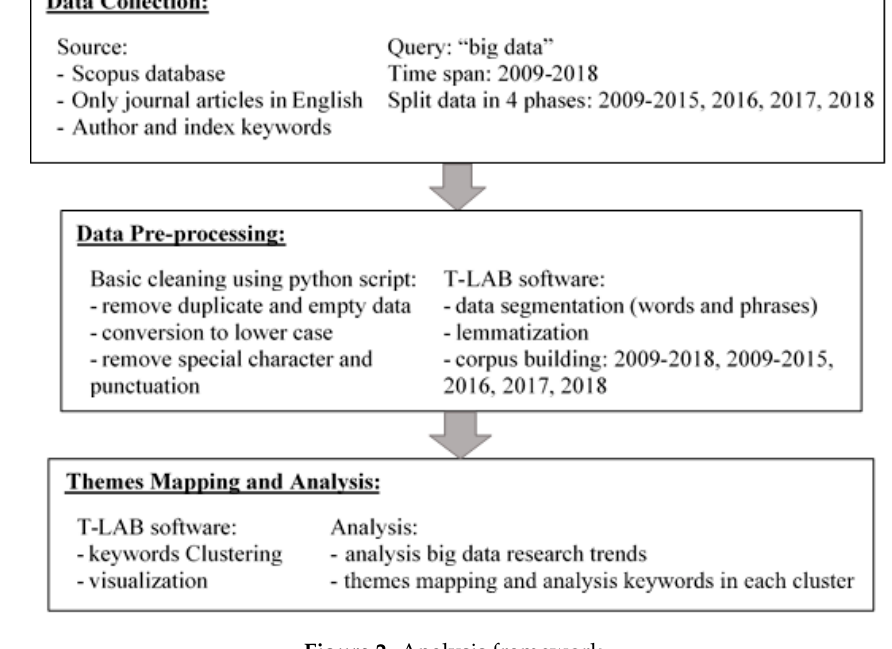
Figure 2. Analysis framework.